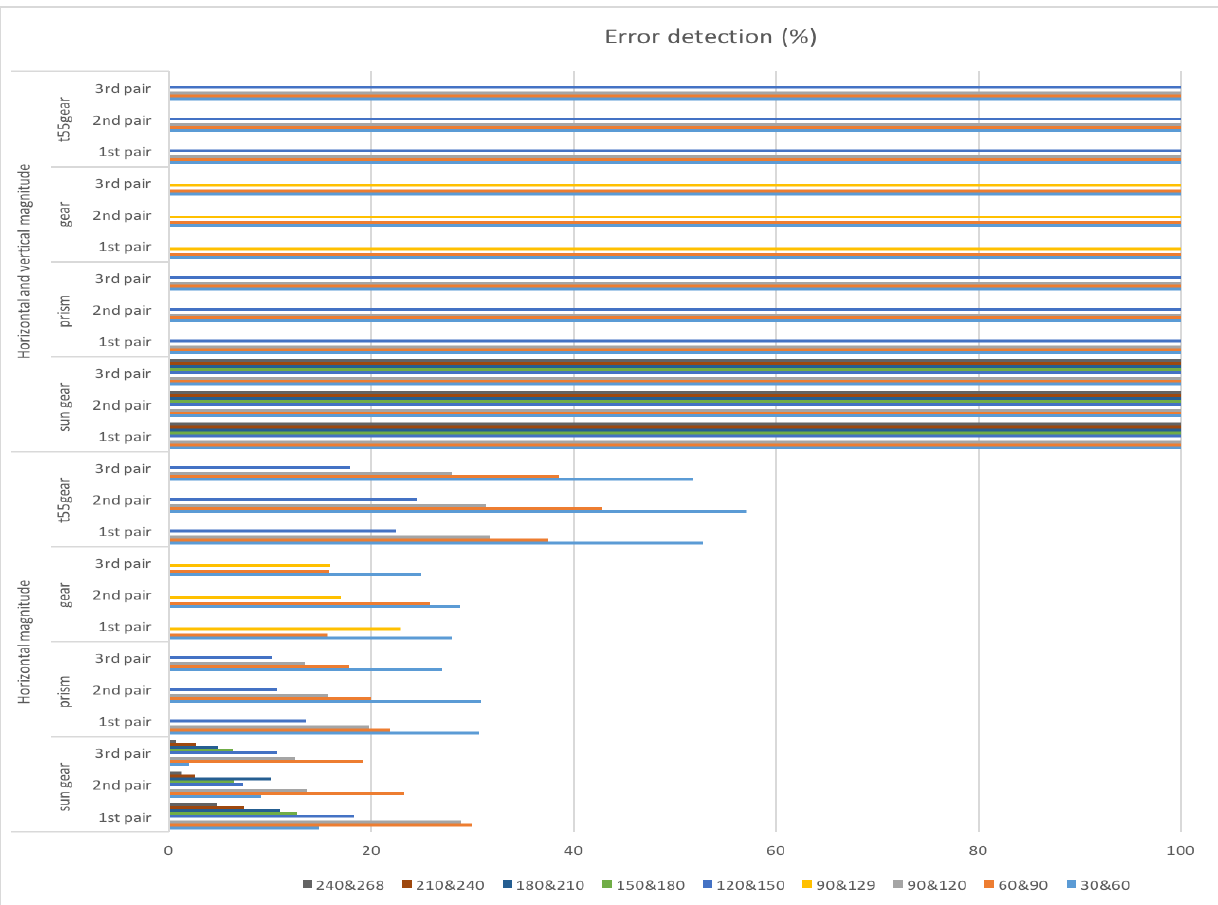
Figure A7. Summary of error detection: the error detection of failure state for ( a ) sun gear; ( b ) prism; ( c ) gear; and ( d ) t55gear.